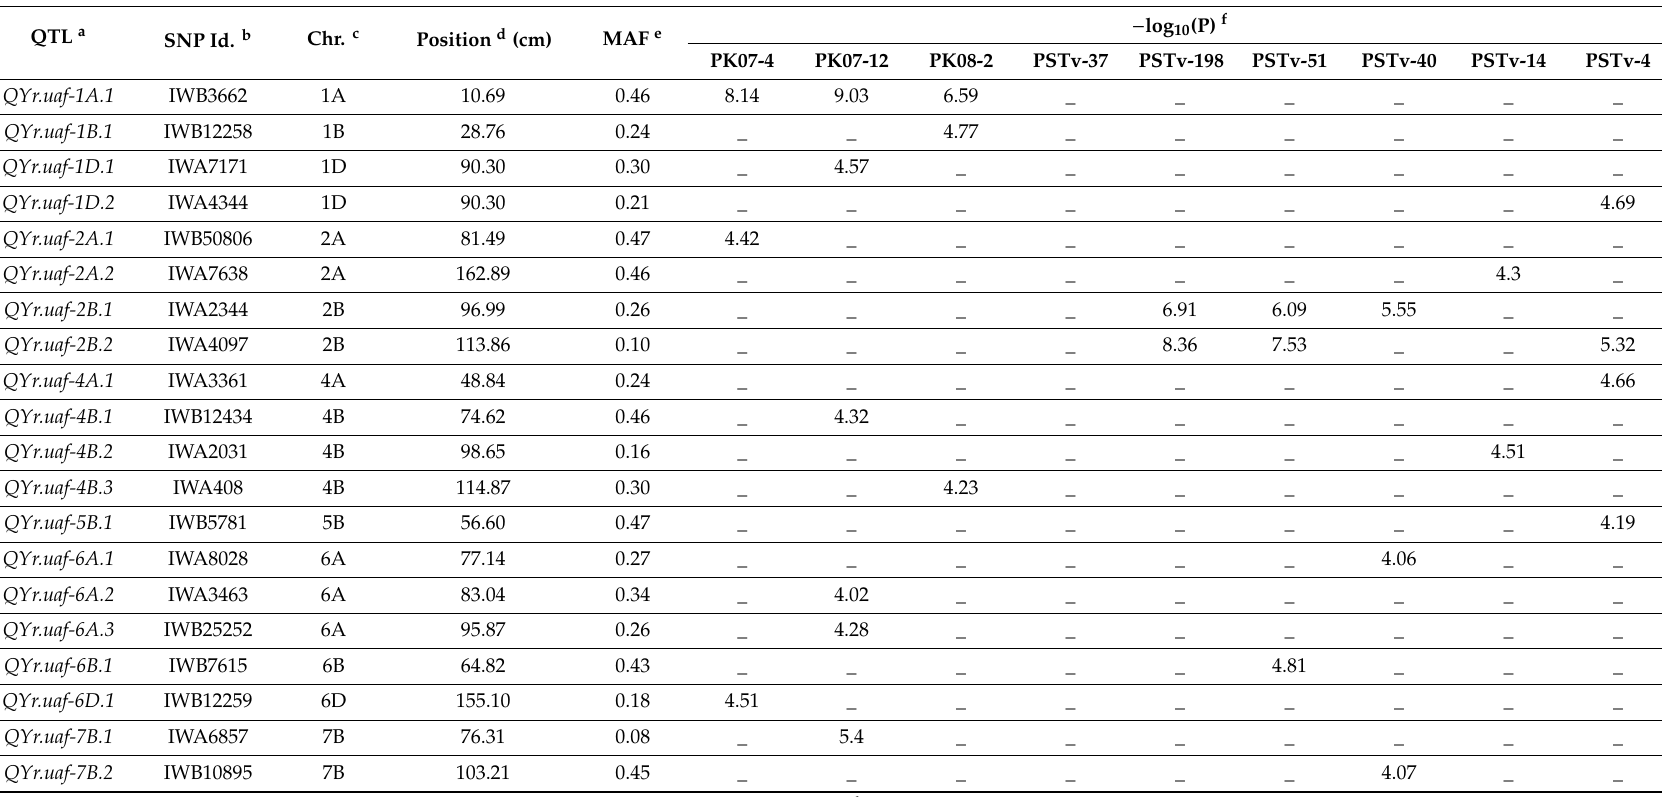
Table 2. SNPs associated with the seedling response to nine Pst races in 465 genotypes of wheat ( p <